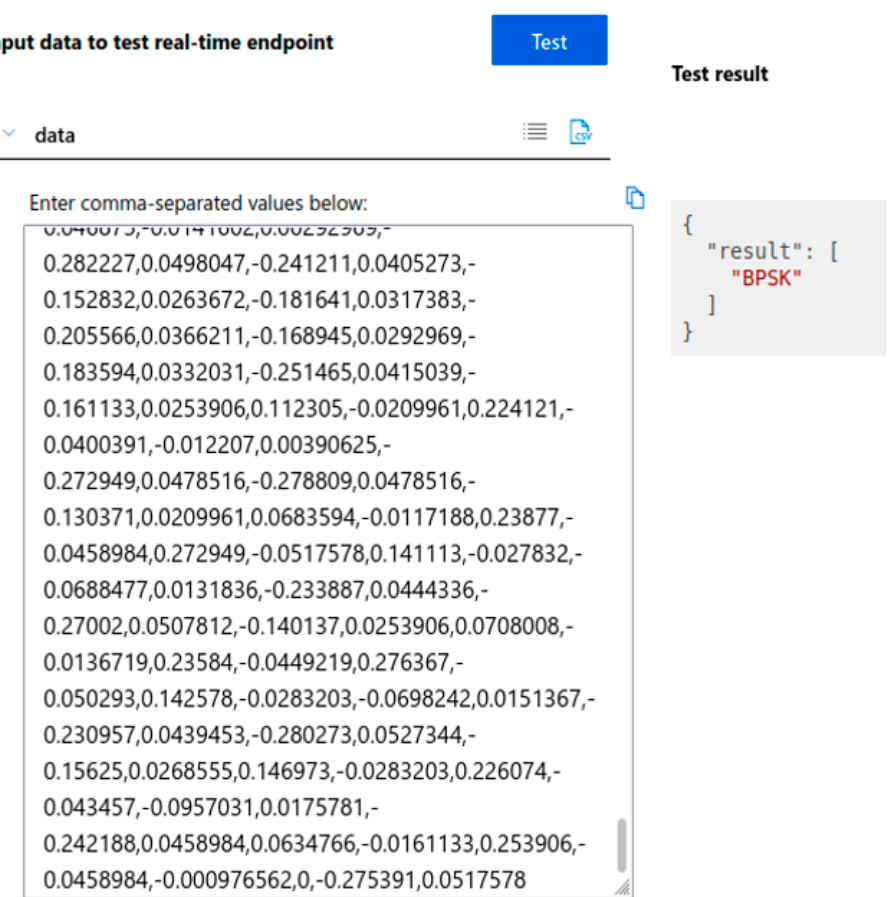
Figure 6. Received BPSK signal test.